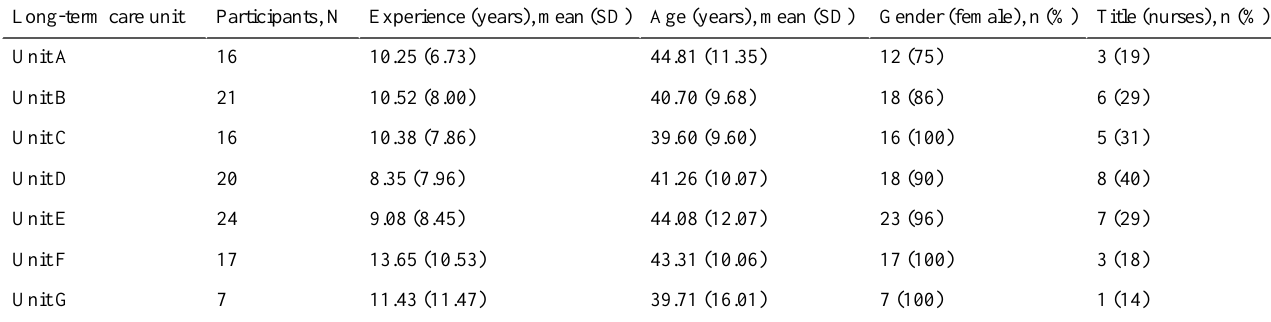
Table 2. Demographic characteristics for each participating long-term care